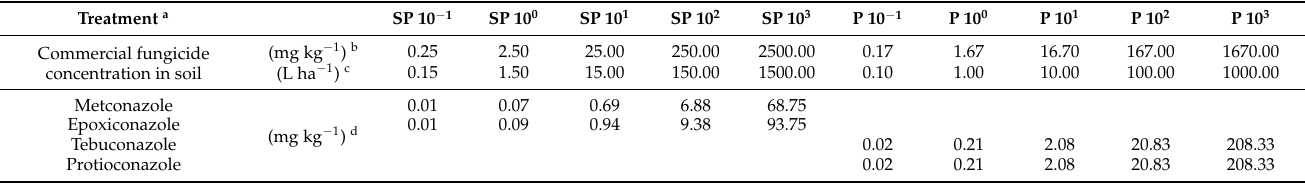
Table 1. Test substance and active ingredient concentrations for treatments with SWING PLUS ® and PROSARO ® in Toxicity test 1.